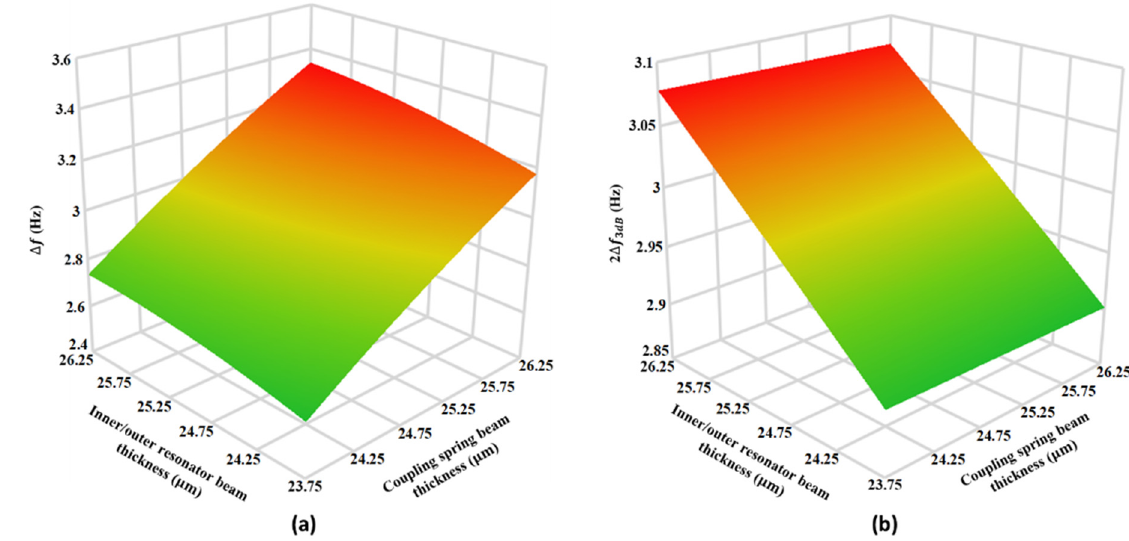
Figure 19. The response surface plots for the effect of the ± 5% variation in the beams thickness of inner/outer resonators and coupling springs on ( a ) ∆ f and ( b ) 2 ∆ f 3 dB .